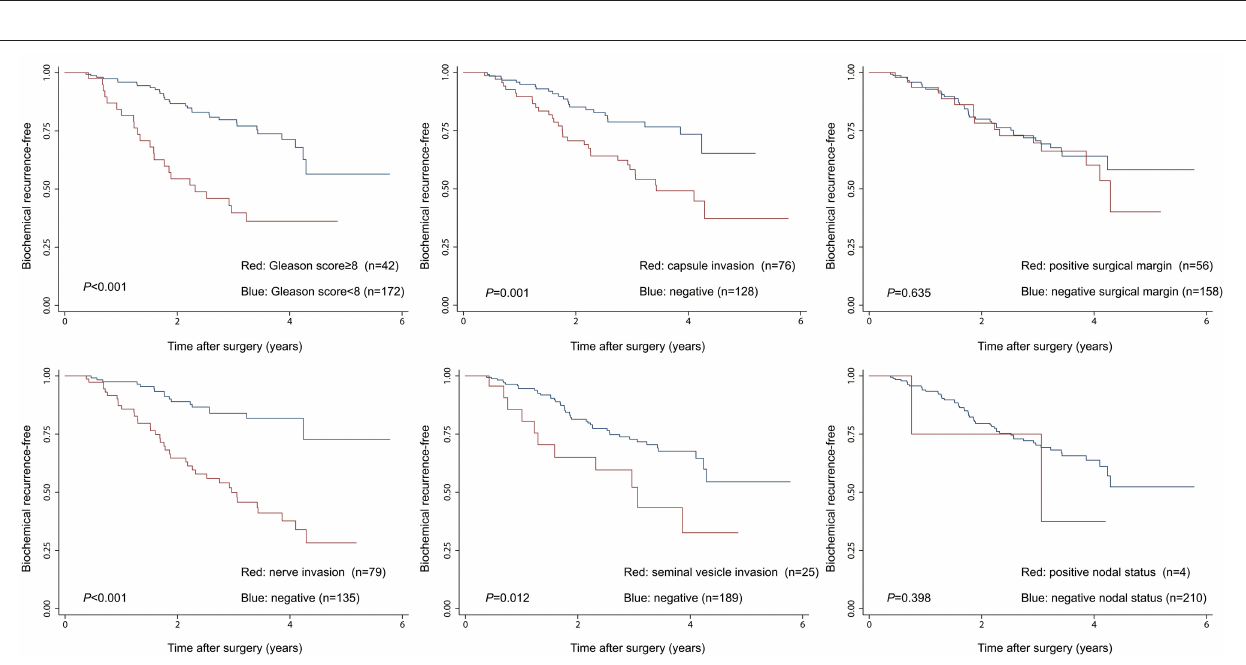
FIGURE 1 | The Kaplan-Meier analysis for BCR-free survival according to the presence of MetS and its components. The log-rank test was performed to determine the statistical significance between the two groups.